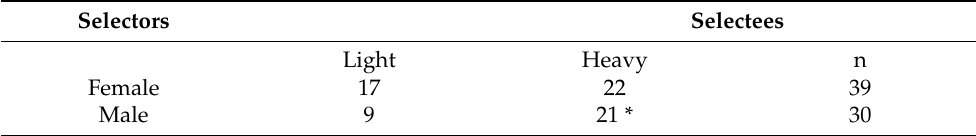
Table 2. Influence of body weight on A. curvicauda mate selection. All insects were 6–8 d. Selectors Selectees Light Heavy n